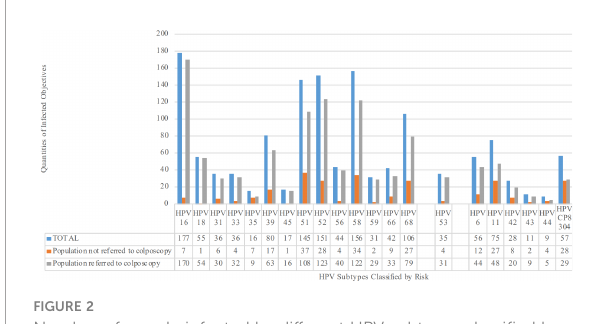
FIGURE 2 Number of people infected by different HPV subtypes classi fi ed by risk. HR-HPV subtypes include HPV16, 18, 31, 33, 35, 39, 45, 51, 52, 56, 58, 59, 66, and 68. Suspected HR-HPV subtypes include HPV53. LR-HPV subtypes include HPV6, 11, 42, 43, 44, and